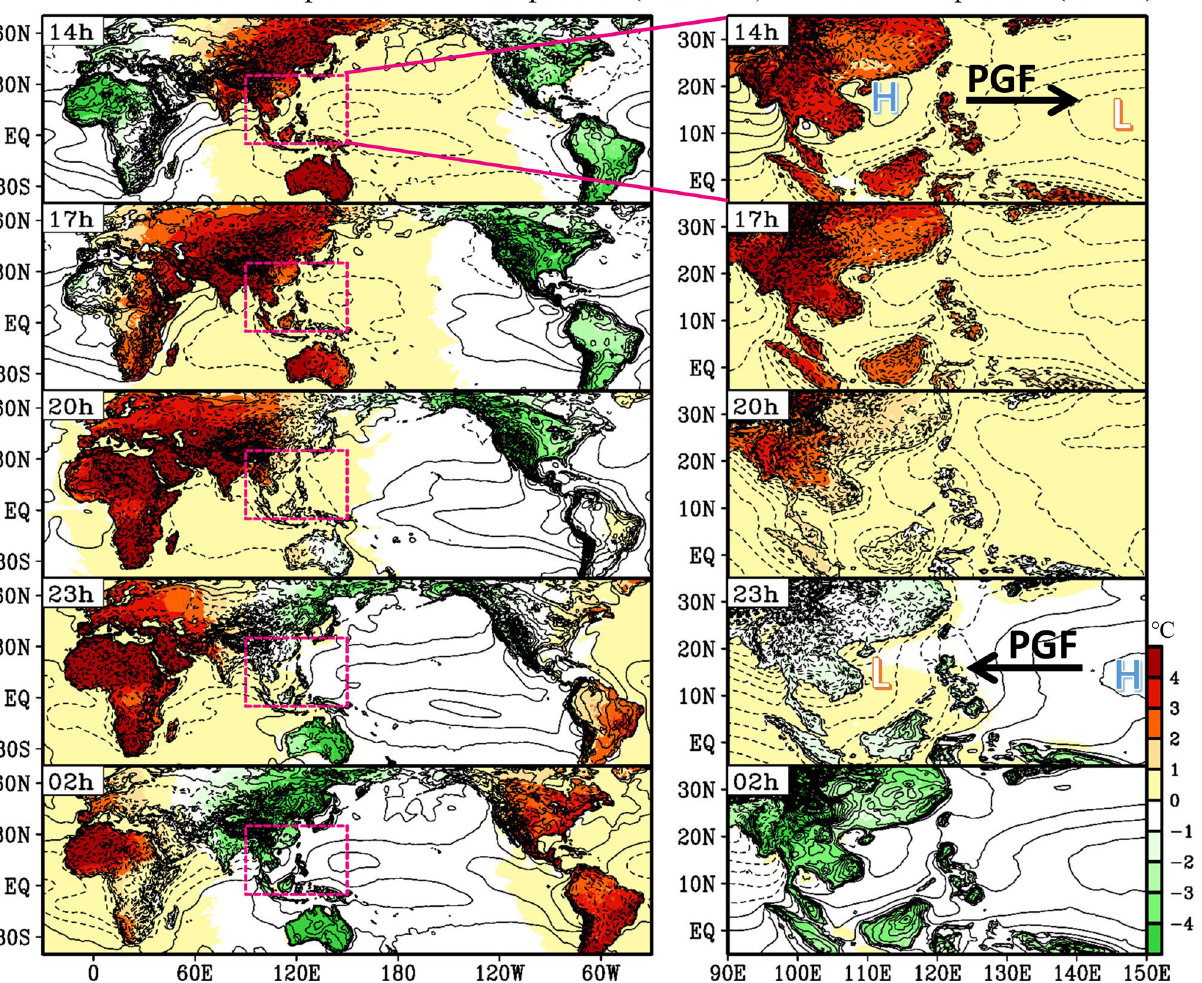
Figure 7. Horizontal distribution of the diurnal harmonic component of the sea level pressure (SLP, contour) and surface temperature (Ts, shaded) averaged during 2001–2019 spring. The left (right) panel represents the domain covering global longitudinal region (EAWNP region). The times (14–02 h) represent the local time in the Philippines. The contour interval is 0.1 hPa. The black arrows are added in the right panel to help indicate the direction of the pressure gradient forcing (PGF) induced by the east–west contrast of high pressure system (denoted by H) and low pressure system (denoted by L). This figure is created using the software of GrADS